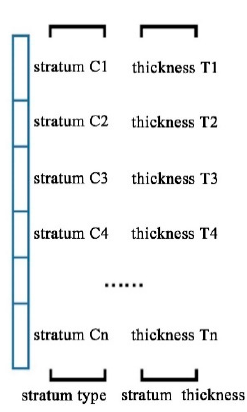
Figure 1. Geostratigraphic series diagram.